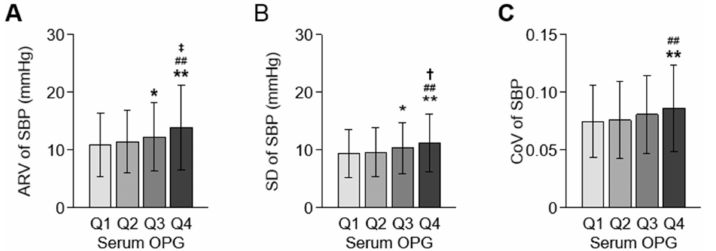
Figure 2. Comparisons of systolic BPV by serum OPG level. Systolic BPV, represented by ARV ( A ), SD ( B ), and CoV ( C ), is compared by the quartile of serum OPG level. Error bars indicate